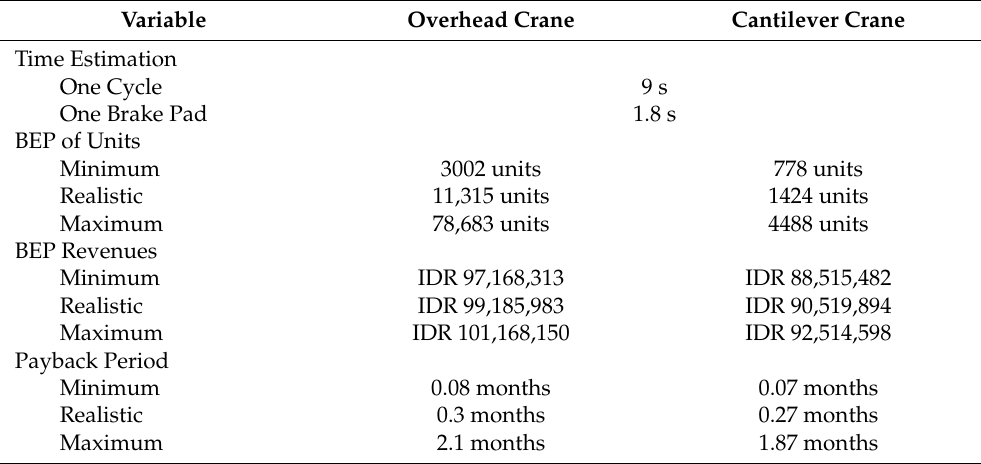
Table 11. Summary of the Results of Overhead Crane and Cantilever